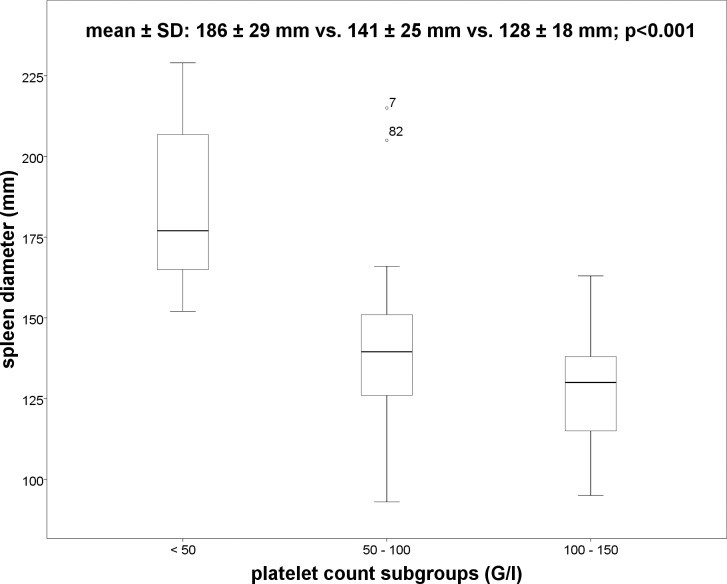
Boxplot: Spleen diameter and platelet count subgroups.